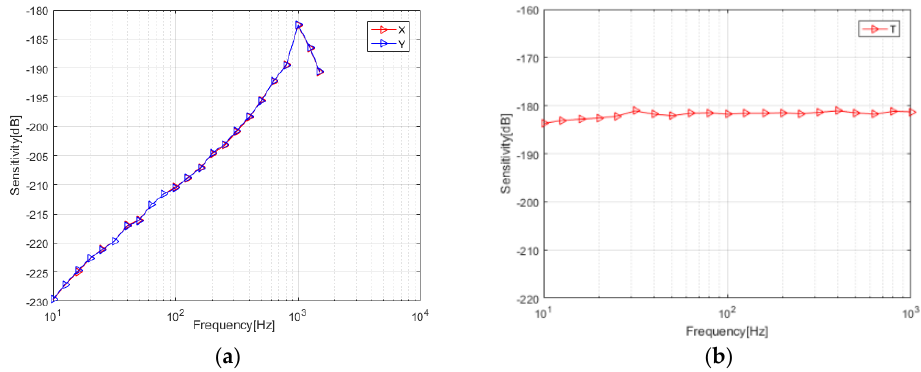
Figure 6. Sensitivity curve of sensor. ( a ) Vector channel; ( b ) scalar channel.